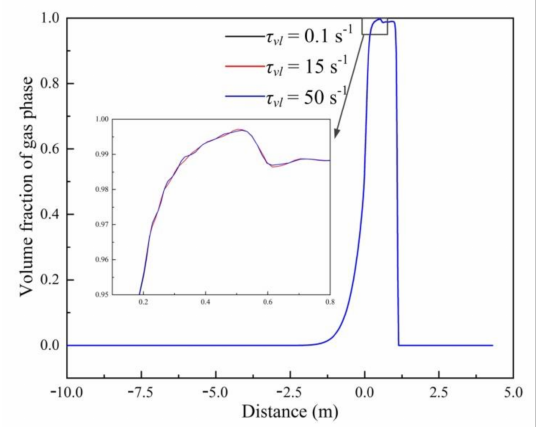
Figure 4. Effects of condensation coefficient τ vl on volume fraction of gaseous CO 2